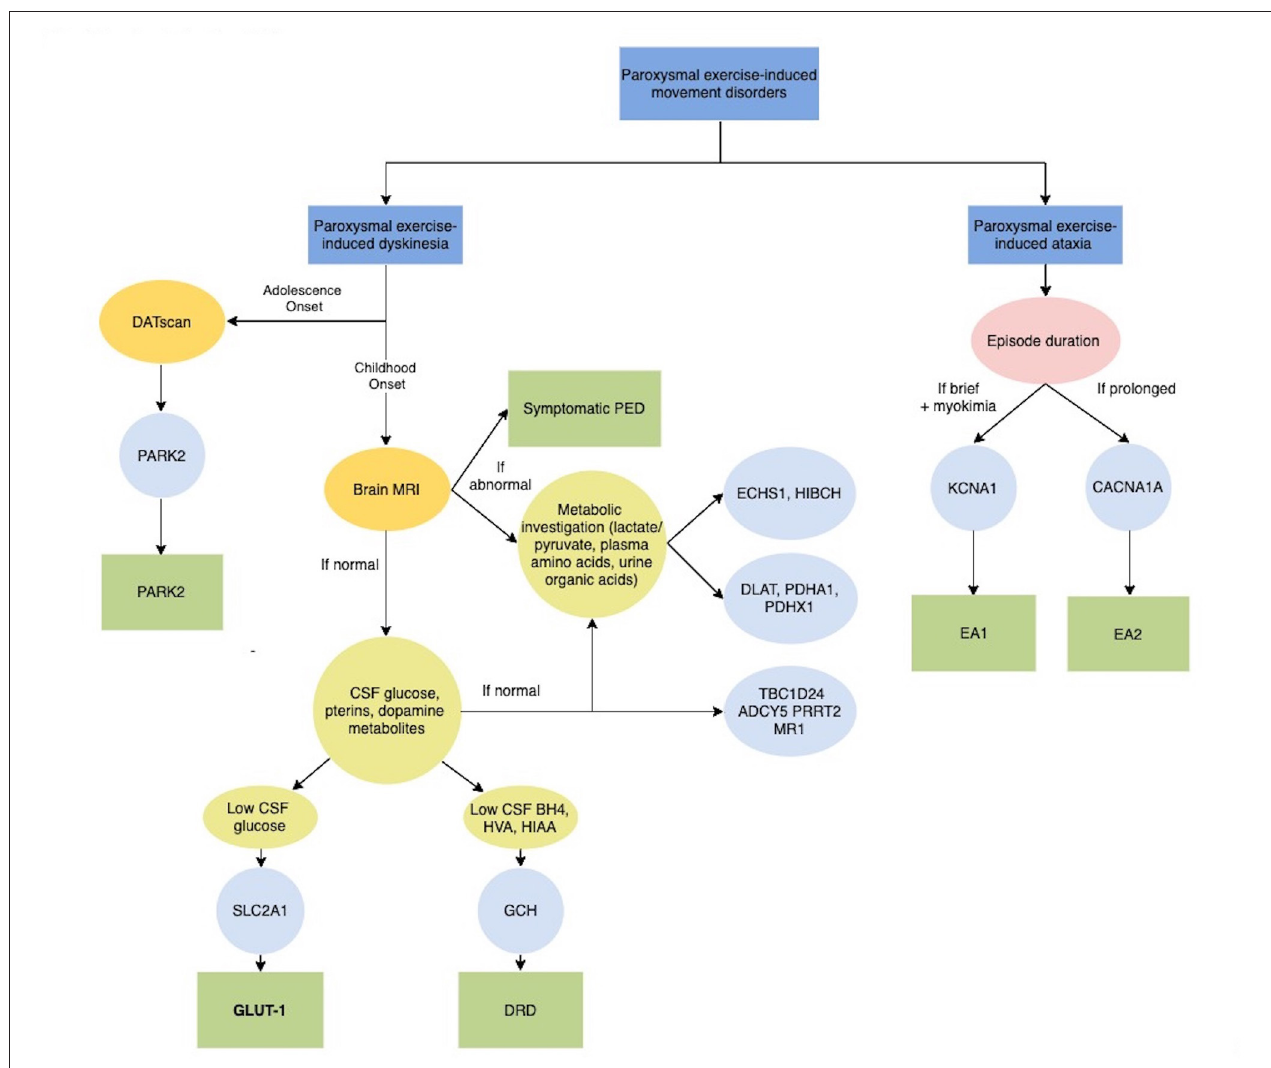
FIGURE 2 | Diagnostic algorithm for Paroxysmal exercise-induced movement disorders. ADCY5, Adenylate Cyclase 5; BH4, tetrahydrobiobterin; CACNA1A, Calcium Channel, Voltage-Dependent, P/Q Type, Alpha-1a Subunit; CSF, Cerebrospinal fluid; DATscan, Dopamine transporter (DAT) single photon emission computerized tomography (SPECT) imaging technique; DLAT, Dihydrolipoamide acetyltransferase; DRD, Dopa-Responsive Dystonia; EA1, Episodic Ataxia, Type 1; EA2, Episodic Ataxia, Type 2; ECHS1, Short-chain enoyl-CoA hydratase; GLUT-1, Glucose Transport Defect, Blood-Brain Barrier, Deficiency Syndrome 1; GCH, GTP